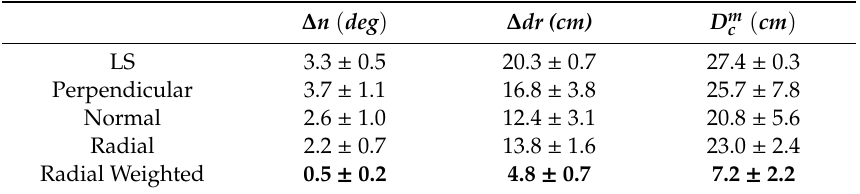
Table 3. Mean value of metrics for the second experiment.